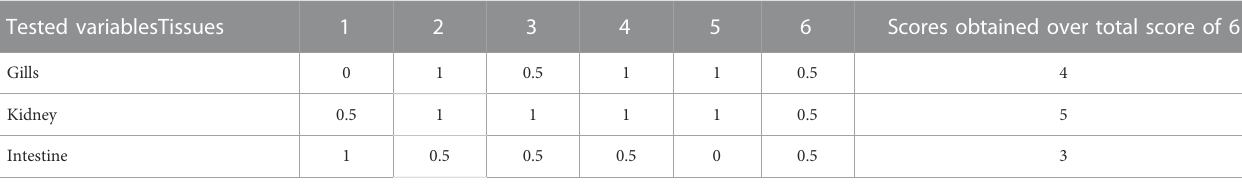
TABLE 4 Qualitative measurement of parabola of different tested variables generated from integrative parabola model based on the action of melatonin treatment in immersion-stressed climbing perch. Tested variablesTissues 1